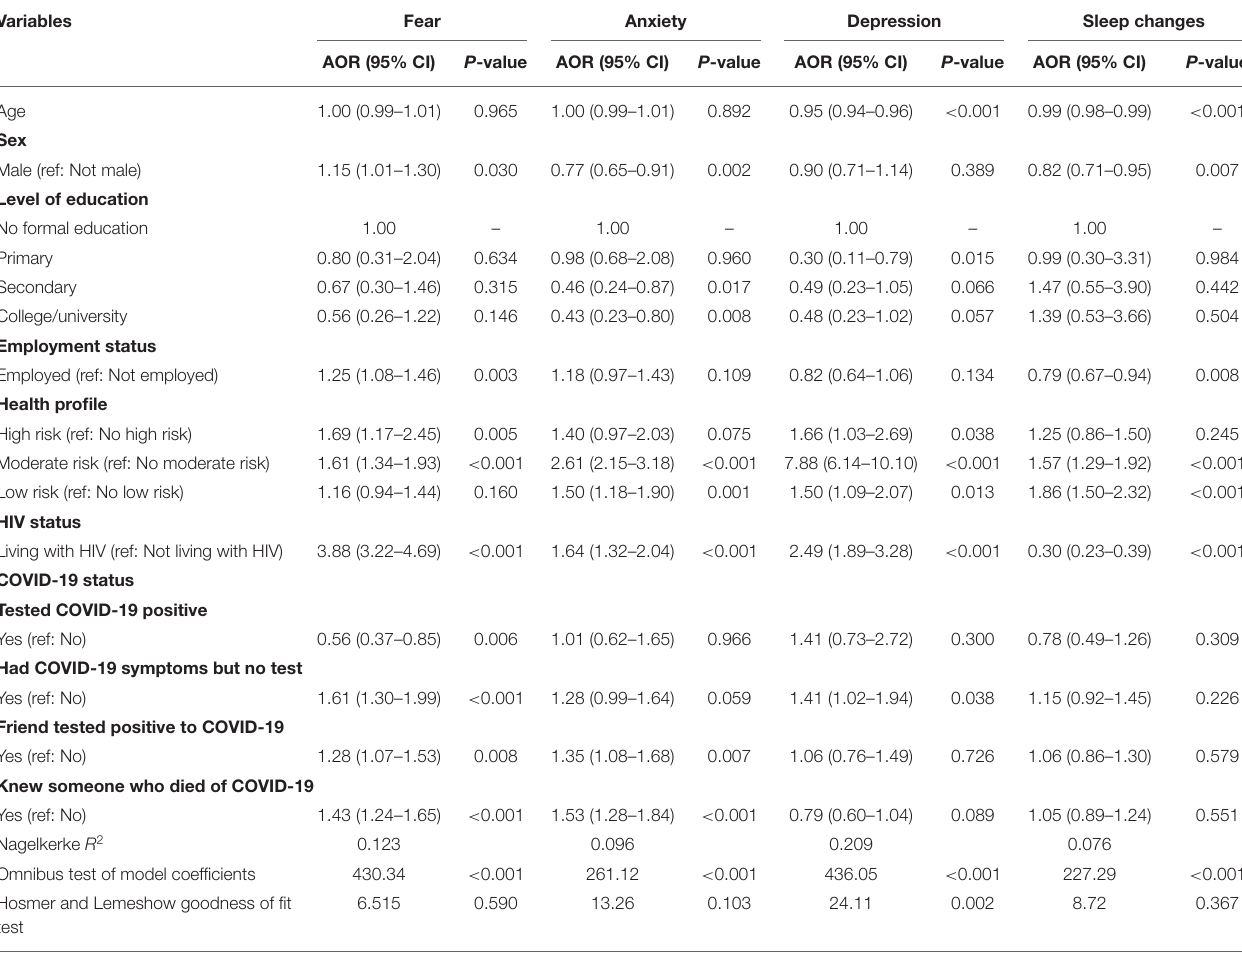
TABLE 2 | Logistic regression analysis for factors associated with anxiety, depression and sleep changes during the COVID-19 pandemic by adults in Nigeria ( N = 4,439).